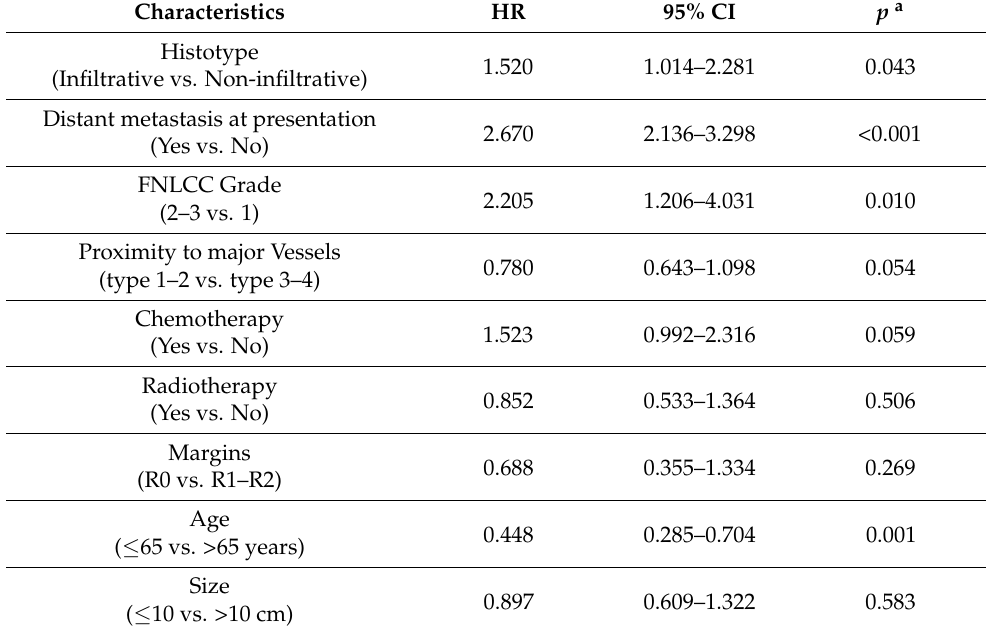
Table 3. Multivariate analysis for overall